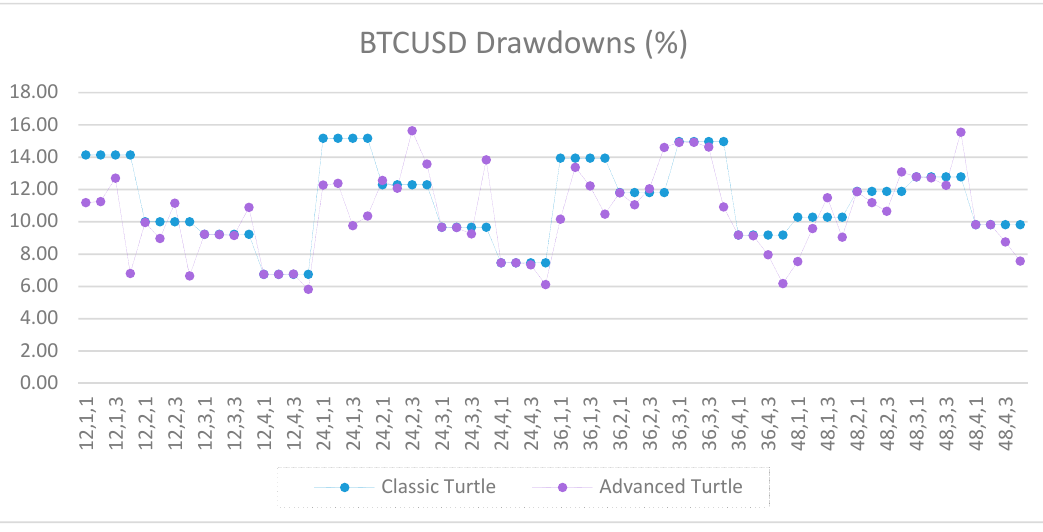
Figure A48. Drawdowns of BTCUSD as percentage of equity between the classic and the advanced Turtle systems for every combination of N, X, Y for the slow parameters (80, 160).